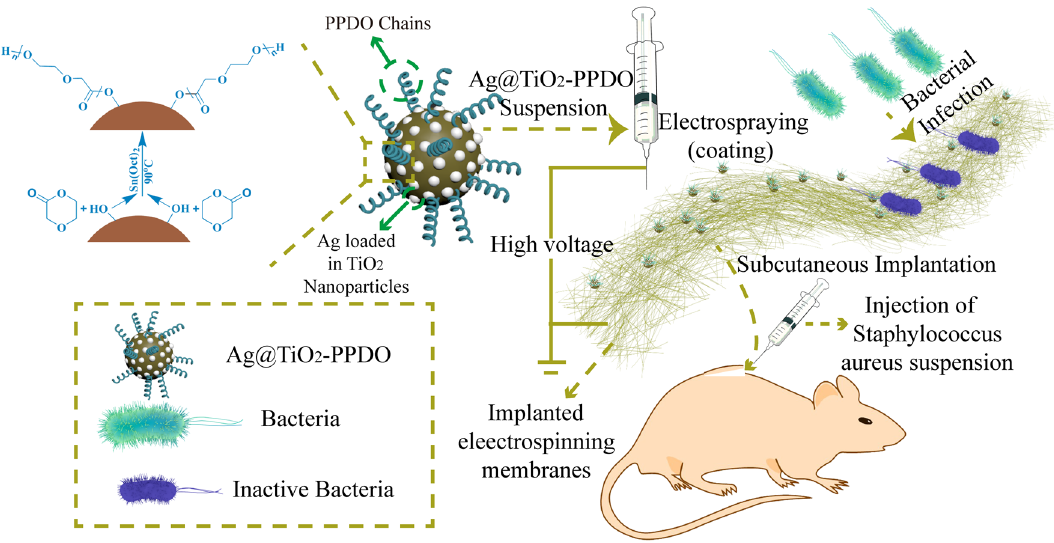
Figure 1. Synthetic processes of Ag@TiO 2 -PPDO and Ag@TiO 2 NP-coated PLGA/PLCA electrospinning